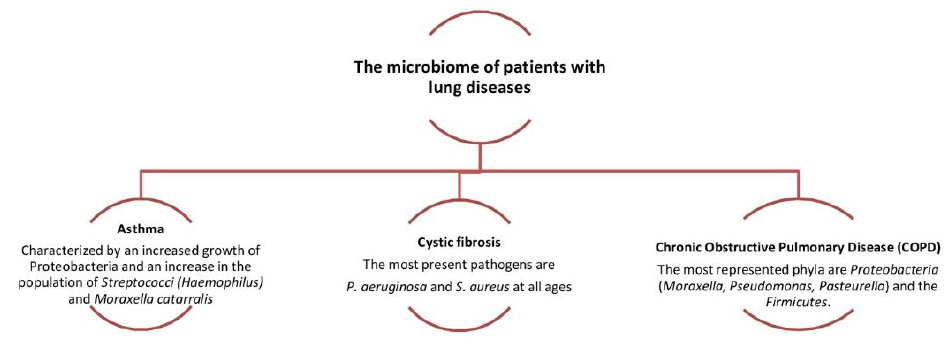
Figure 4. Dysbiosis related to some lung diseases. The relative abundance in Proteobacteria is associated with the increased severity of chronic obstructive pulmonary disease (COPD).